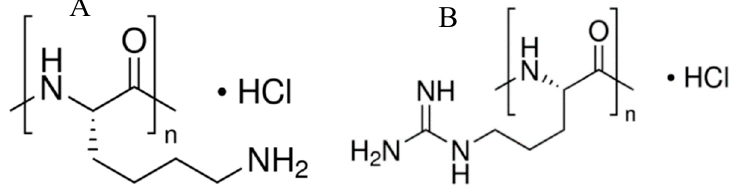
Figure 2. Structures of ( A ) poly-L-lysine (PLL) and ( B ) poly-L-arginine (PLArg).